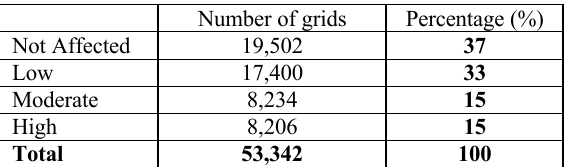
Table 3. Total number of grids in Sta. Cruz, Zambales Barangay